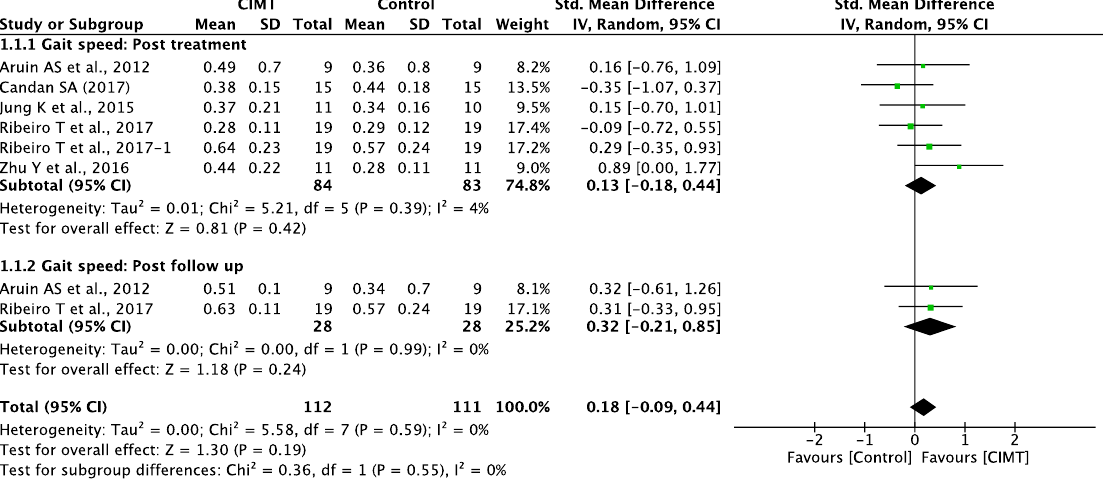
Figure 3. Gait speed: post-treatment and post-follow-up. (Tedla, 2022) The meta-analysis results for balance in the post-treatment CIMT group were unable to display a significant difference in balance when compared to the control groups; the SMD was 4.94 at 95% CI = −2 .48 – 12.67, p = 0.19, with substantial heterogeneity among the studies (I 2 = 92% at p < 0.001). In addition, in studies reporting follow-up of treatment ses- sions, the CIMT group was unable to display a significant difference in balance when compared to the control groups (SMD = 3.84 at 95% C I = − 2.33 – 10.01, p = 0.22); the hetero- geneity among the studies was I 2 = 88% at p = 0.004 (Figure 4). Figure 4. Balance: post-treatment and post-follow-up. (Tedla, 2022) 4. Discussion This review discusses the qualitative and quantitative effects of LECIMT on the nu- merous parameters that determine functional ambulation. The current review is unique compared to previous reviews because it primarily observed gait and balance cardiopul- monary parameters exclusively among RCTs. The gait outcome measures were exten- sively reported in seven studies [50 – 52,54 – 56,58,59], followed by balance in four studies [53,56,58,59], cardiovascular fitness [50], functional mobility [53], functional ambulation